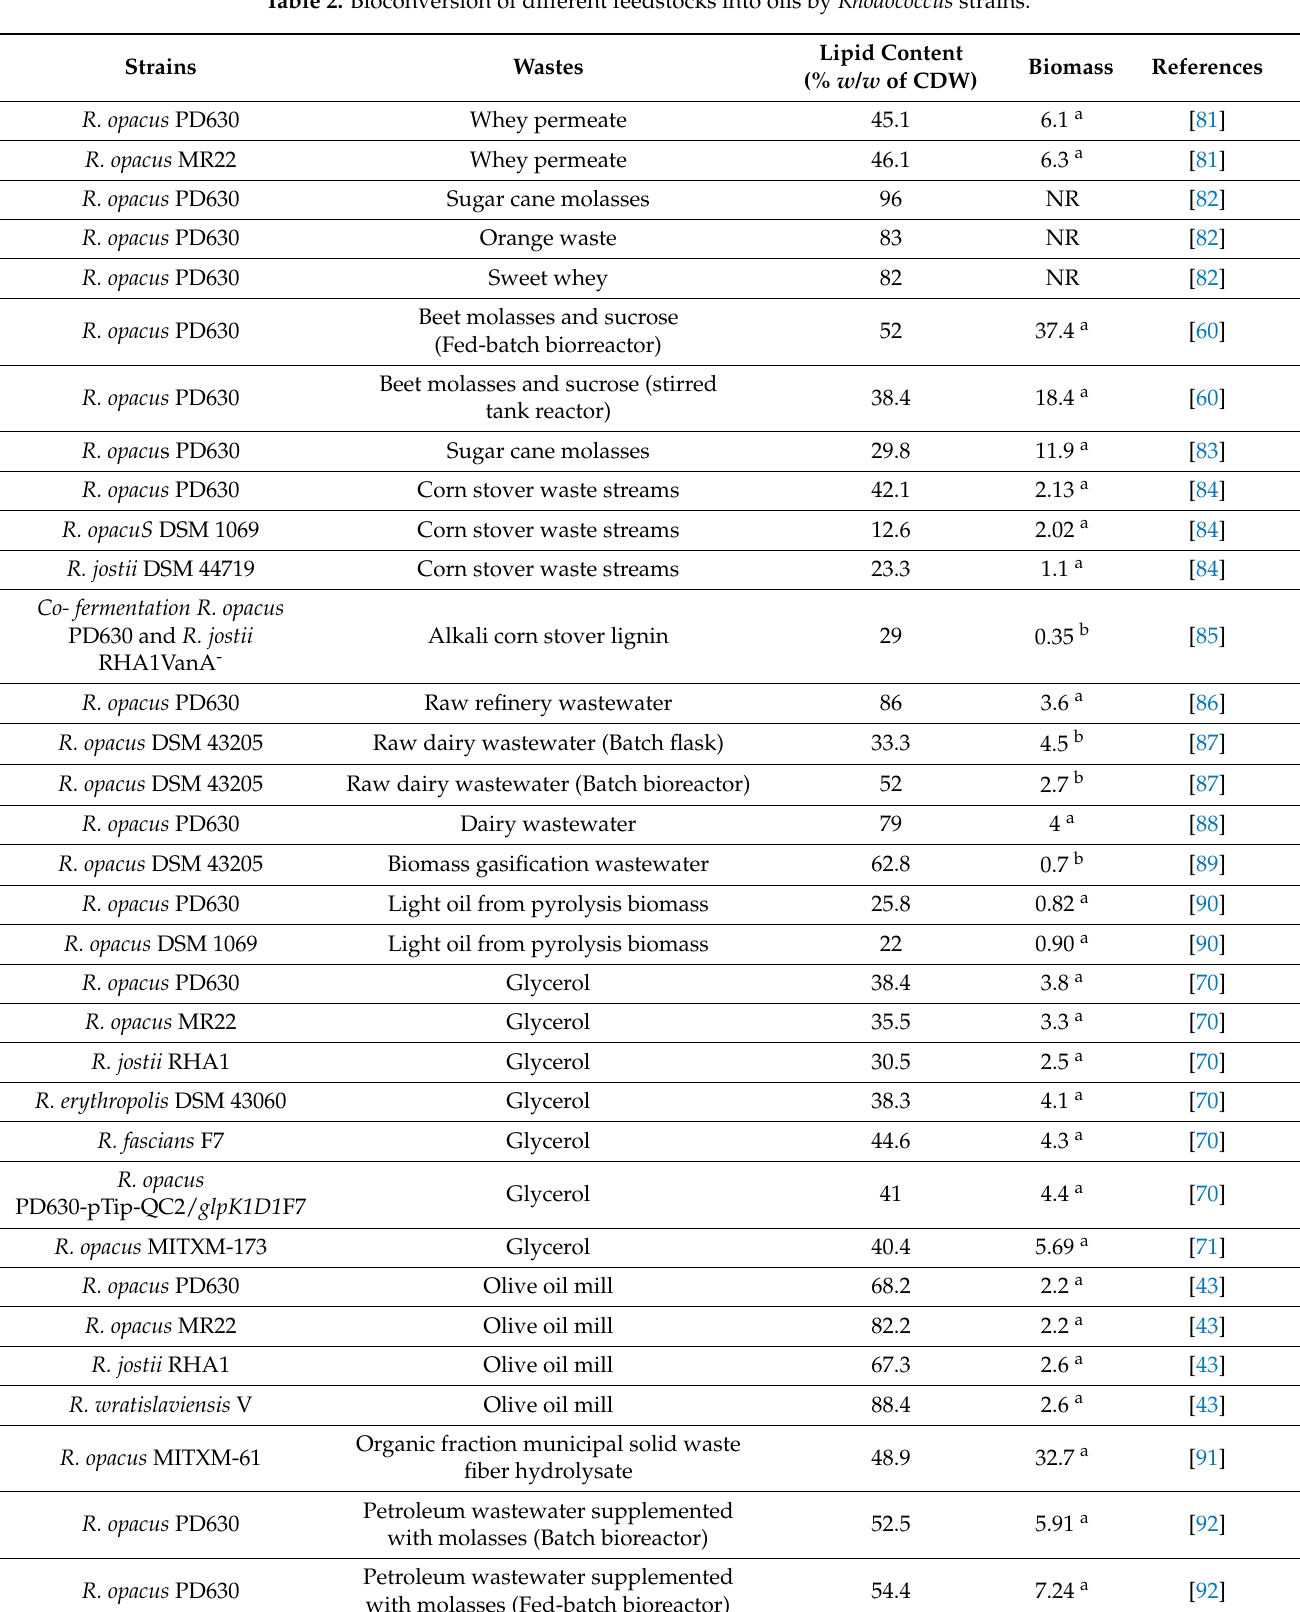
Table 2. Bioconversion of different feedstocks into oils by Rhodococcus